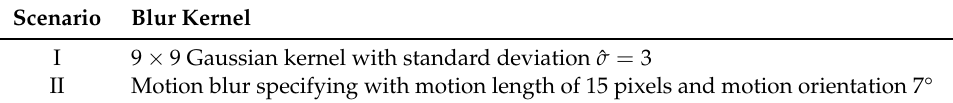
Table 3. Description of image blurring scenarios.